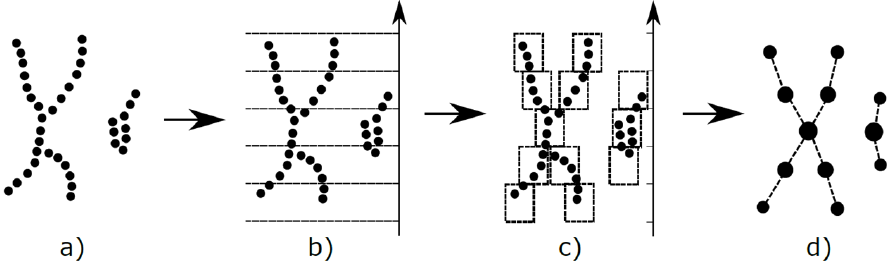
Figure 2. Illustration of M APPER for the case when k = 1; i.e., f : X → R 1 . Refer to the descriptions